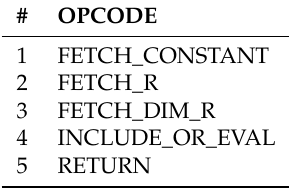
Table 1. Dump of the opcode